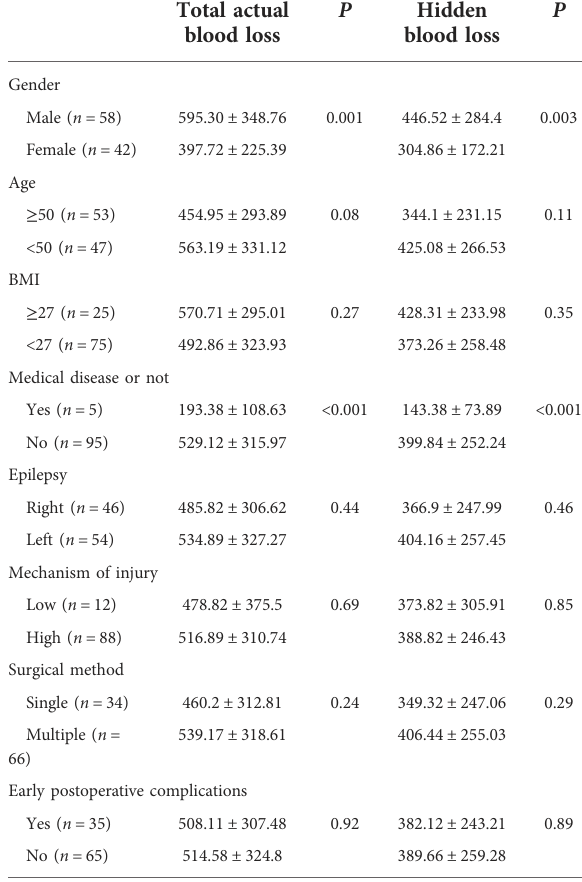
TABLE 2 Characteristics of included